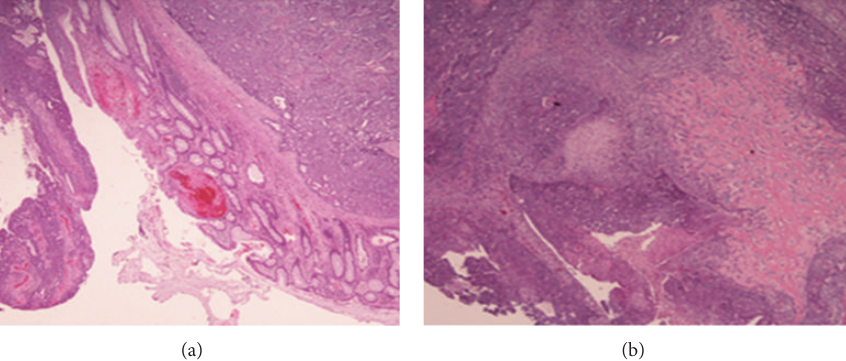
Figure 4: (a) H&E (2x) lower-power microscopic view of the resection specimen with an epithelioid malignancy involving the large intestine; (b) H&E (4x bone and cartilage) low-power view showing both malignant epithelial and mesenchymal elements. The epithelioid component consists of malignant glandular elements with squamous differentiation. The heterologous component (on the right) consists of a malignant osteoid.